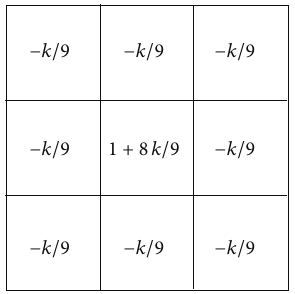
Figure 7: The kernel for unsharp masking.